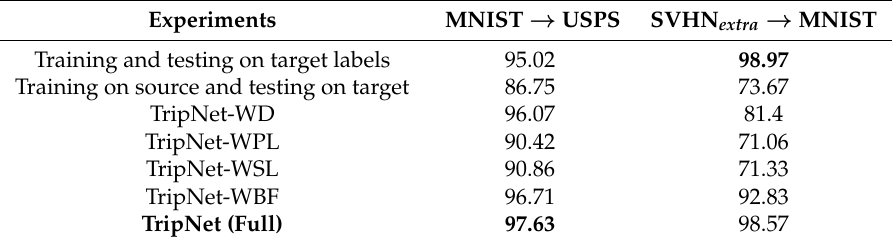
Table 4. Test accuracy for the ablation study for